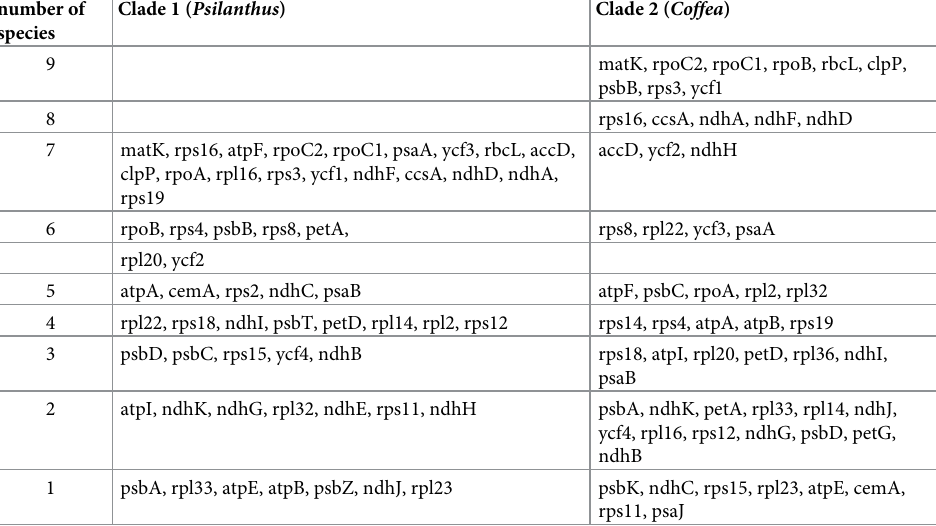
blotiana : rps16 , rpoC1 , clpP , and ndhA; C . dolichophylla : rps16 , rpoC1 , and clpP; C . macrocarpa : clpP and ndhA .